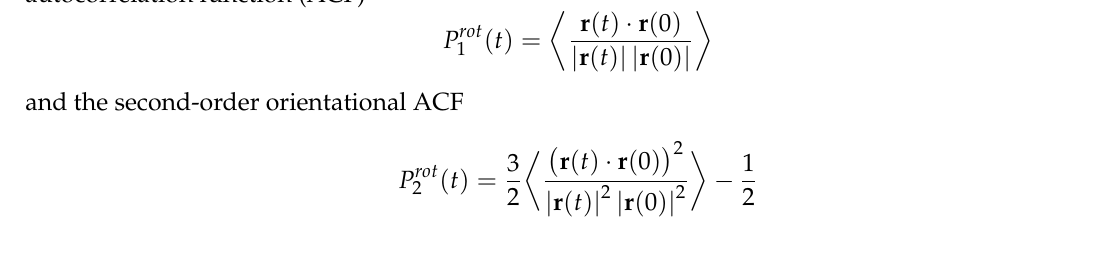
g values at temperature